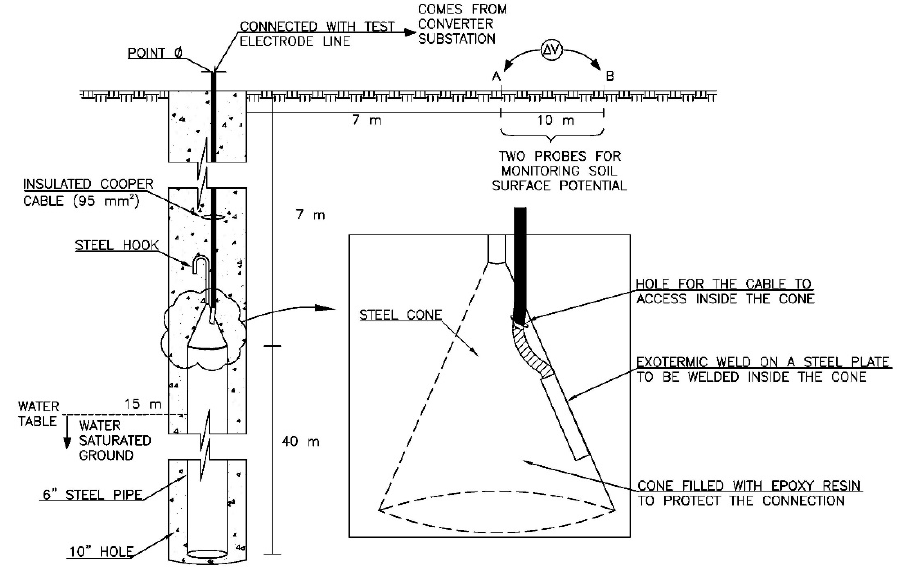
Figure 3. Test-electrode configuration.